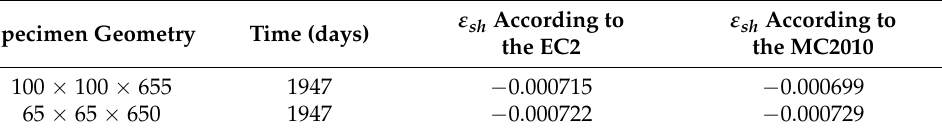
Table 2. Free shrinkage predicted by the Euro Code 2 (EC2) and the CEB-fib Model Code 2010